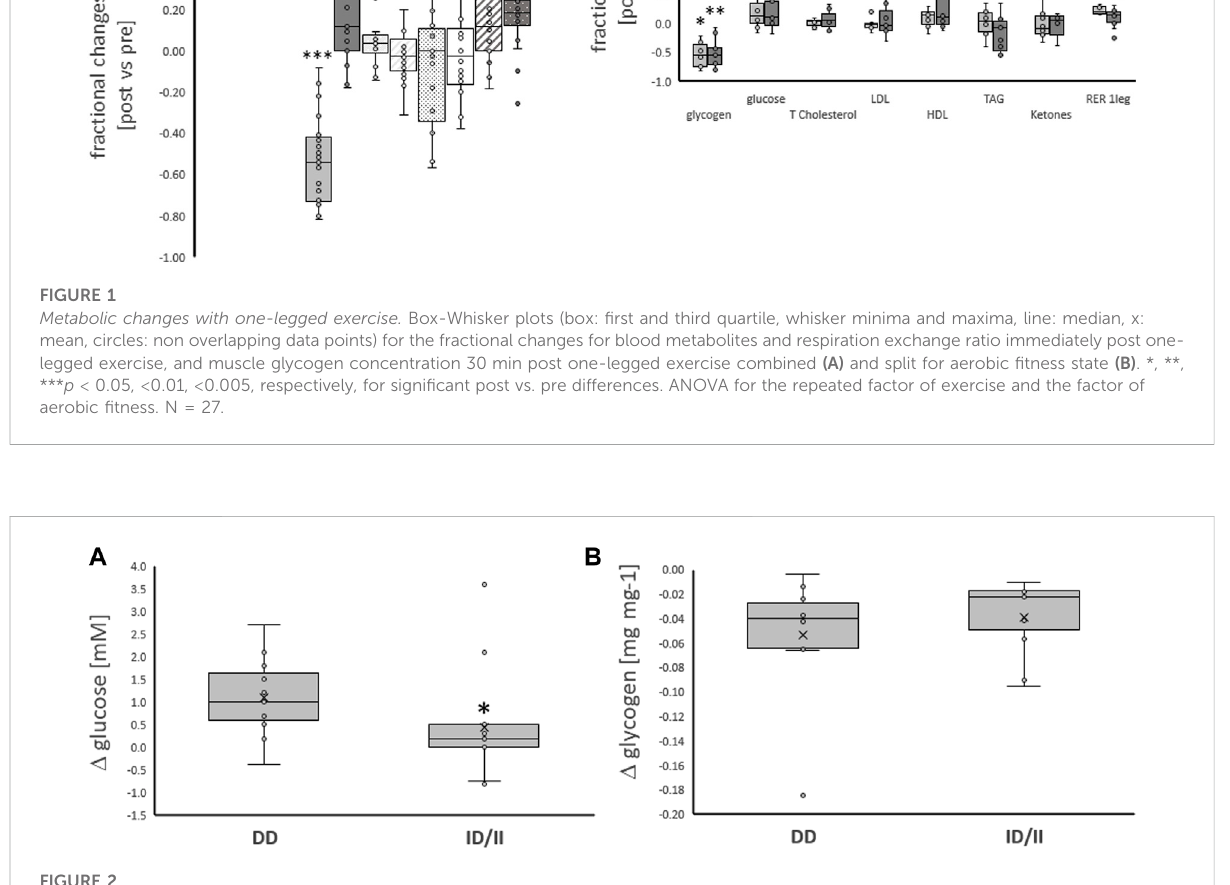
FIGURE 2 Exercise-induced alterations of glucose metabolism related compounds per genotype. Box-Whisker plots of the differences in the concentration of blood glucose (A) and muscle glycogen (B) immediately and 30 min, respectively, after one-legged exercise in carriers (ACE-ID/II) and non-carriers (ACE-DD) of the ACE I-allele. *, p < 0.05 for post vs. pre differences between genotypes. ANOVA for the factor ACE-I/D genotype. N =